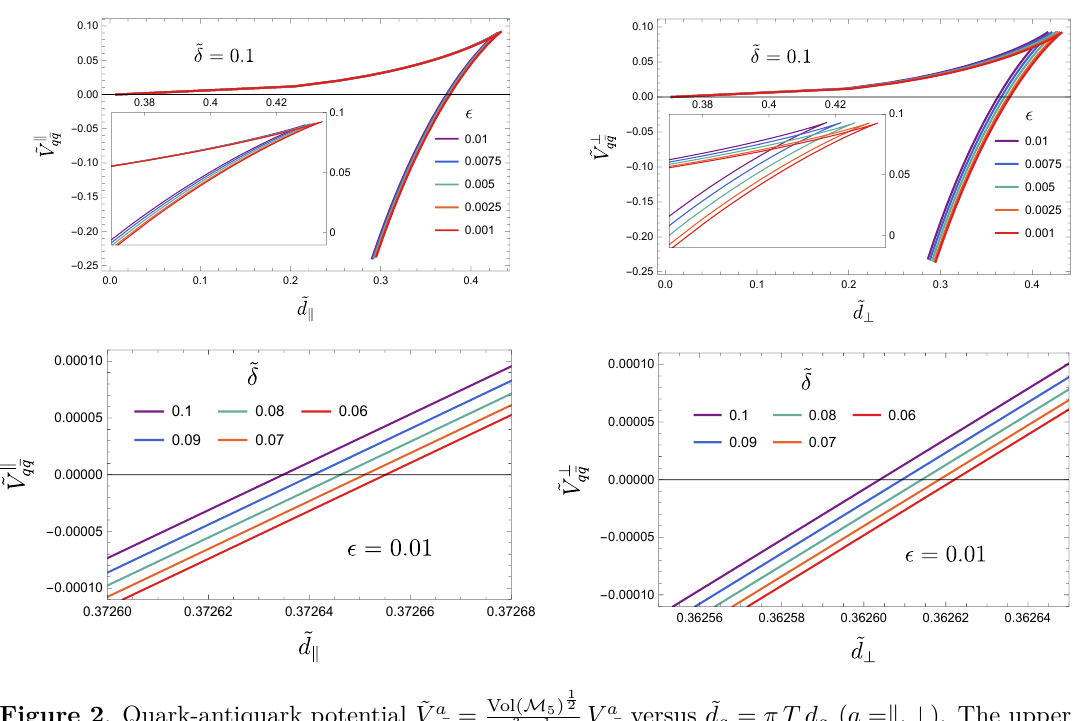
1 2 = Vol( M 5 ) V a versus ˜ d a = π T d a ( a = k , ⊥ ). The upper q ¯ q q ¯ q π 3 2 λ 1 2 T